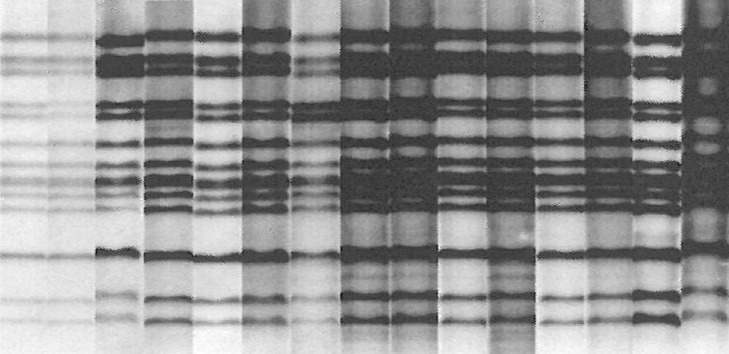
RFLP results of 15 active TB cases with positive AFB culture.The banding patterns of 15 outbreak strain isolates are completely same. RFLP = restriction fragment length polymorphism; TB = tuberculosis; AFB = acid fast bacilli.